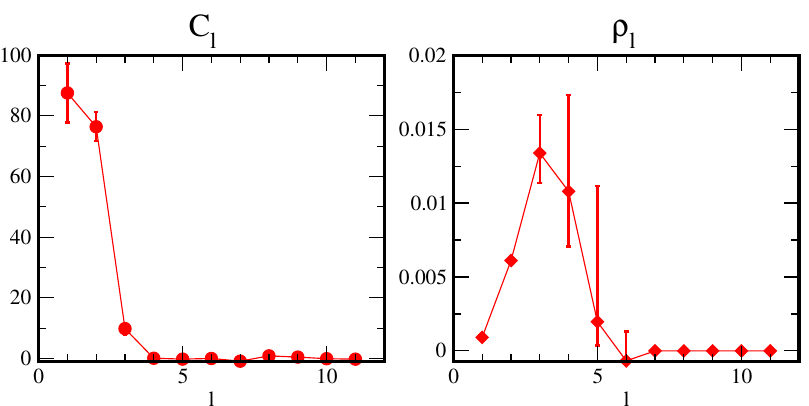
Figure 12 . The correlation function and the spectral function in the IR basis as a function of l . The (cid:13)ow-time of the data is t=a 2 = 1 : 50.